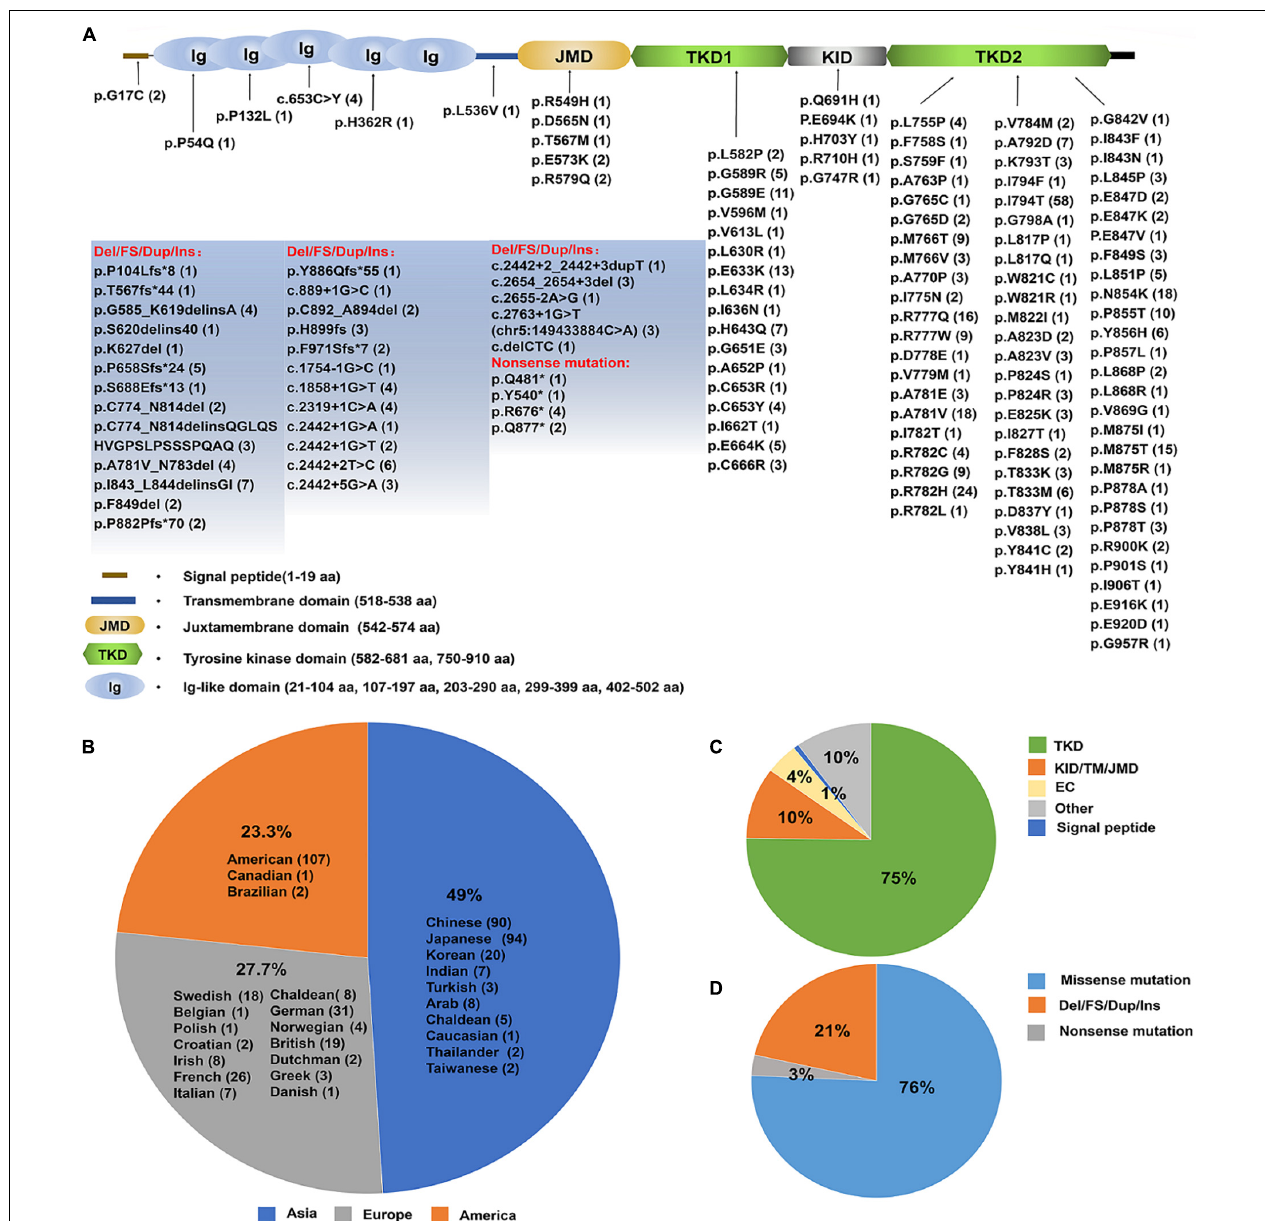
FIGURE 5 | An update on the spectrum of CSF1R mutations causing ALSP. (A) A diagram of CSF1Rprotein structure. The brown line represents N-terminal signal peptide of CSF1R. Ig1–Ig5 ovals represent the five extracellular Ig-like domains of CSF1R. The transmembrane domain is illustrated in light blue. The intracellular domain is shown as the juxtamembrane domain (JMD, light yellow), tyrosine kinase domain (TKD, light green), kinase insert domain (KID, light gray) and carboxy-terminal tail (black). The TKD of CSF1R is interrupted by the KID. Up to date, a total of 140 pathogenic mutations have been identified (indicated and listed below). The numbers in the parentheses represent the number of reported cases. (B) Emerging cases have been reported in the United States, Europe and Asia. The number of cases in each region is listed in the parentheses. (C) A pie-chart illustrates the mutation locations for a total of 140 pathogenic CSF1R variants. 64% mutations are located within TKD, 4% within the extracellular domain (ED), and 8% within Juxtamembrane domain (JMD), KID or Transmembrane domain (TM). (D) A pie-chart illustrates the type of mutations for a total of 464 cases with pathogenic CSF1R variants identified up to date, which include point mutations, nonsense mutations, frameshift and deletion mutations. The majority of the CSF1R variants are point mutations. NA, not